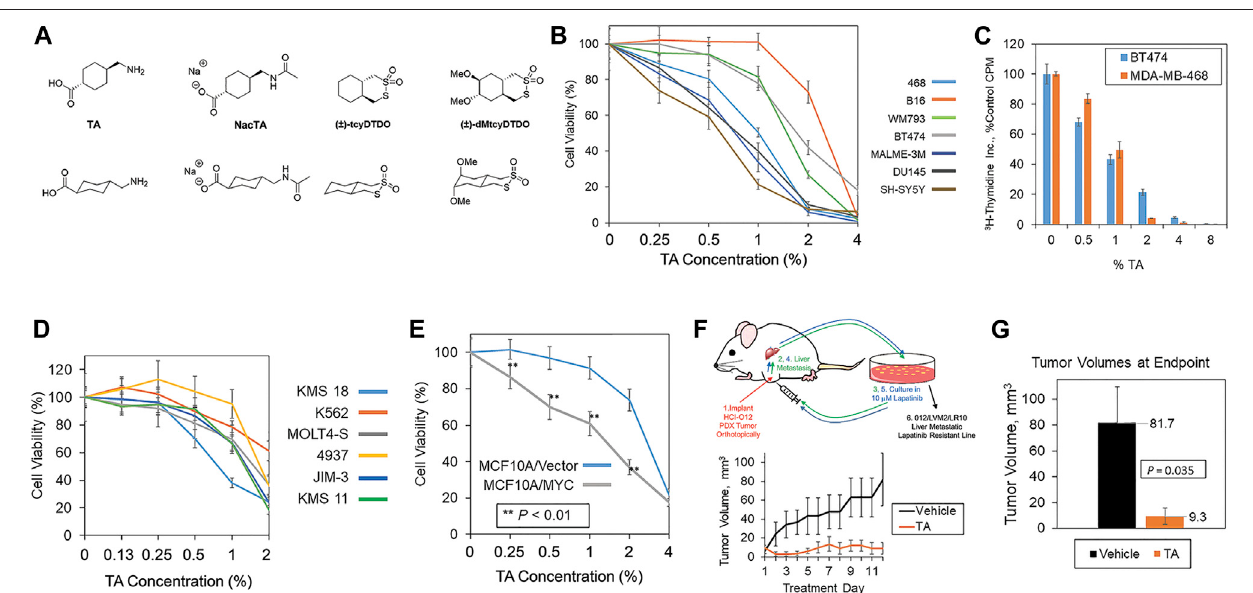
FIGURE 1 | TA decreases cancer cell viability and breast tumor growth. (A) Chemical structures of TA, N -acetylated TA (NacTA), and the DDAs tcyDTDO and dMtcyDTDO. (B) The indicated panel of cancer cell lines were treated for 72 h with different TA concentrations and cell viability was measured using the MTT assay. Resultsaretheaverageofsixreplicatesandpresentedastheaverage ± S.D.These fi ndingsarerepresentativeofthreebiologicalreplicateswithsimilarresults. (C) MDA- MB-468andBT474cellsweretreatedfor24 hwiththeindicatedconcentrationsofTAandtheincorporation oftritiated thymidineintoDNAwasevaluated.Results are the average of six replicates and presented as the average ± S.D. These fi ndings are representative of three biological replicates with similar results. (D) Effects of TA on the viability of a panel of leukemia, lymphoma, and multiple myeloma cell lines. Results are the average of six replicates and presented as the average ± S.D. These fi ndings are representative of three biological replicates with similar results. (E) Cell viability assay showing that TA more potently reduces the viability of MCF10A mammary epithelial cells overexpressing MYC compared with the vector control line. Statistically signi fi cant differences between the lines were observed at 0.25, 0.5, 1, and 2% TA. p -values were calculated using unpaired Student ’ s t -tests. Results are the average of six replicates and presented as the average ± S.D. These fi ndings are representativeofthreebiologicalreplicateswithsimilarresults. (F) Tumorgrowthstudyinwhichmicebearingorthotopic012/LVM2/LR10mammarytumorsweretreated once daily with 375 mg/kg TA. The upper panel illustrates how the 012/LVM2/LR10 cancer model was derived. Tumor dimensions were measured daily and tumor volumes calculated. Averages of within-group tumor volumes are presented and error bars represent standard error of the mean. (G) Tumor volumes measured at day 12 exhibit a statistically signi fi cant TA-mediated reduction in tumor volume ( p (cid:2) 0.035), with an approximately nine-fold smaller tumor volume in the TA group than the vehicle group. p -values were calculated using an unpaired Student ’ s t -test. Each treatment group contained fi ve